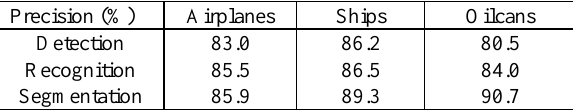
Figure 7. Detection precision with different iteration times